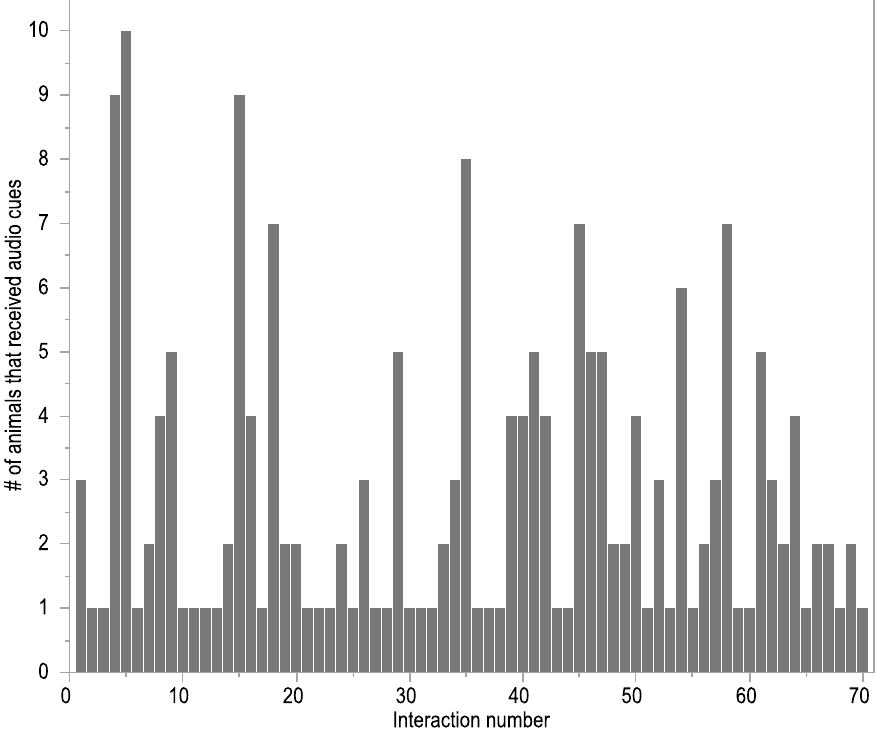
9 of 13 Figure 4. The logistic learning curve for: ( a ) all animals across all combined days; and ( b ) all animals across all combined days but with the grazing algorithm’s two additional audio cues removed. The